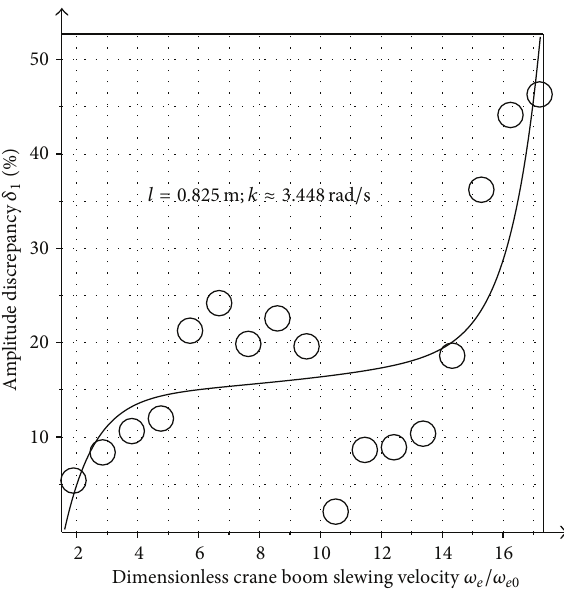
Figure 19: The computational points ( IIII ) and regression diagram (—) for the relative dimensionless amplitude discrepancy 𝛿 1 between averaged radii of computational relative trajectories of payload 𝑀 in the noninertial reference frame F , derived for linearized and nonlinear models in the case of cable length 𝑙 = 0.825